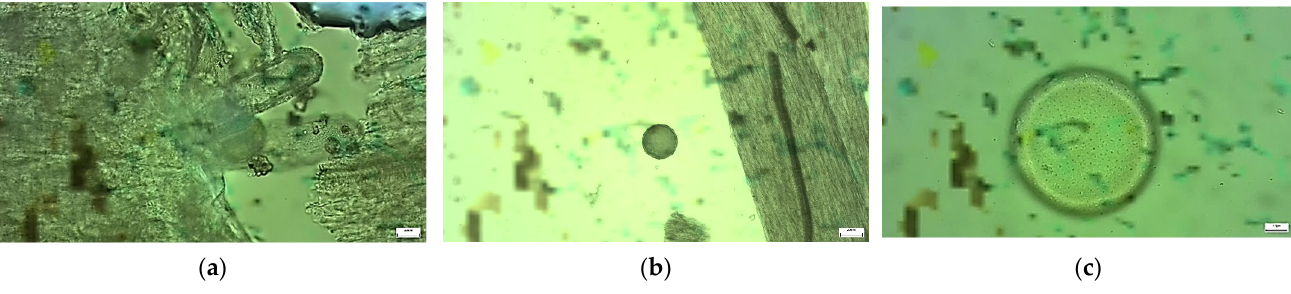
( c ) Figure 10. Fresh flowers of Crocus sativus L. free of stamens and stigmas ( a ); flower dried in 3D configuration ( b ); 3D dried flower conserved in a glass jar ( c ). Some parameters of the flower processing were optimized in the biochemistry labor- atory of the Institute of Methodology for Environmental Analysis in Tito (Potenza), among them, the drying temperature and time. Suitable packaging enabled the dried flower to retain its bright colors for 5 months. 3.6. Daughter Corm Number and Diameter Corms from Spain cultivated in the 2015–2016 and 2016–2017 growth seasons in Pic- erno were compared to each other and with those cultivated in the 2017–2018 growth sea- son in Tricarico. The results highlighted that the lowest number of daughter corms per mother corm was recorded in P1; on the hand, the highest numbers were found in P3 and P4 (Table 5). Nevertheless, the greatest number of daughter corms with a diameter equal to or greater than 2.5 cm was recorded in P1, although the number of mother corms planted was the lowest, both regarding the planted corm numbers per pot and the density. Moreover, the results showed that the daughter corm numbers per mother corm from the P2 trial were similar to those from P3. In turn, daughter corm numbers per mother corm in both the P2 and P3 trials were greater than those of P1, although this latter showed a higher number